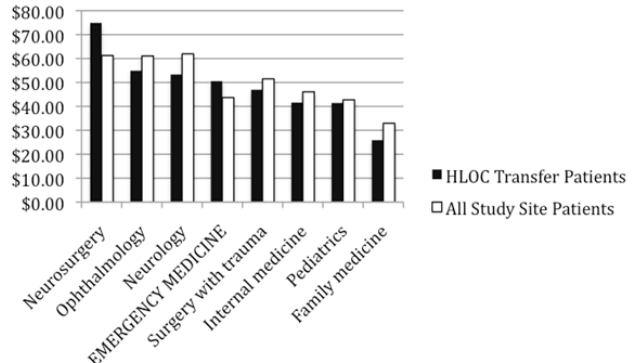
Figure 4 : Reimbursement per relative value unit (RVU) for higher level of care (HLOC) transfer patients vs. all study site patients by specialty (n=8 specialties). All patient data not available at study site for 4 specialties: obstetrics and gynecology, head and neck surgery, orthopedics and plastic surgery.